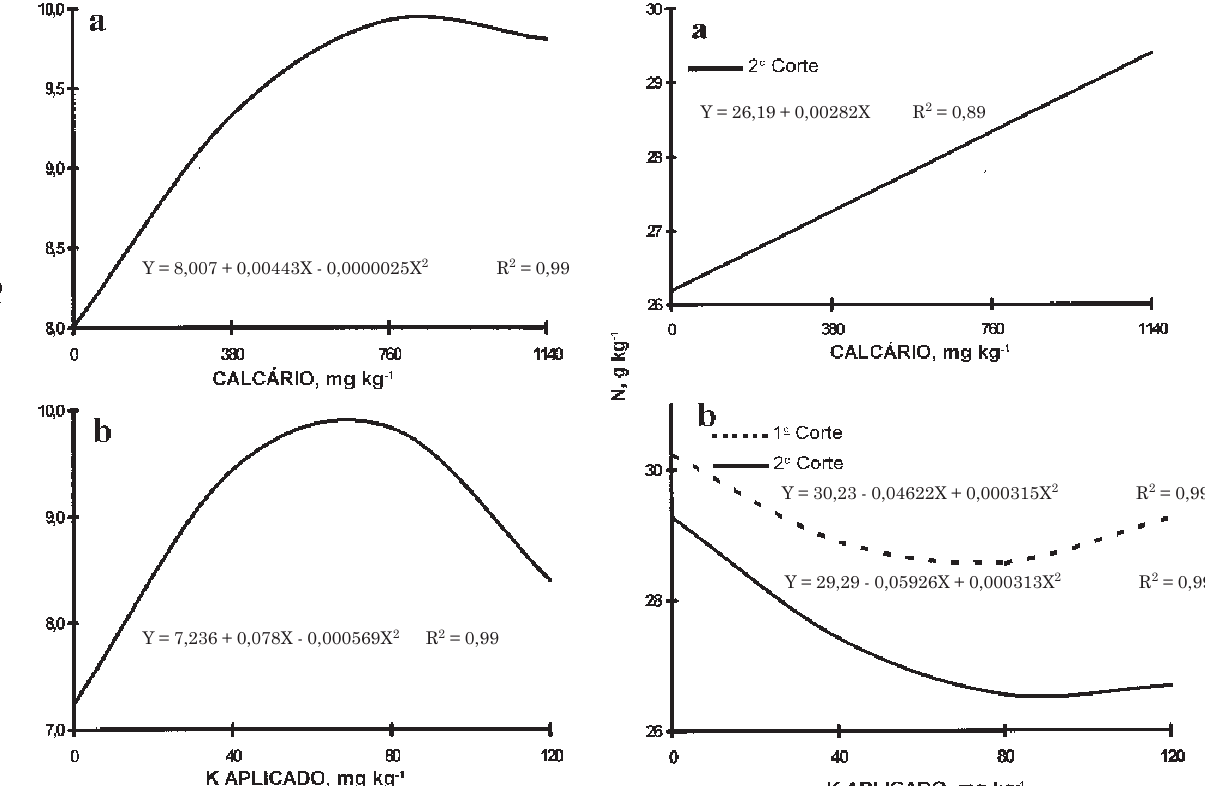
Figura 2. Produção de matéria seca das raízes da alfafa, em função das doses de calcário (a) e de potássio (b).